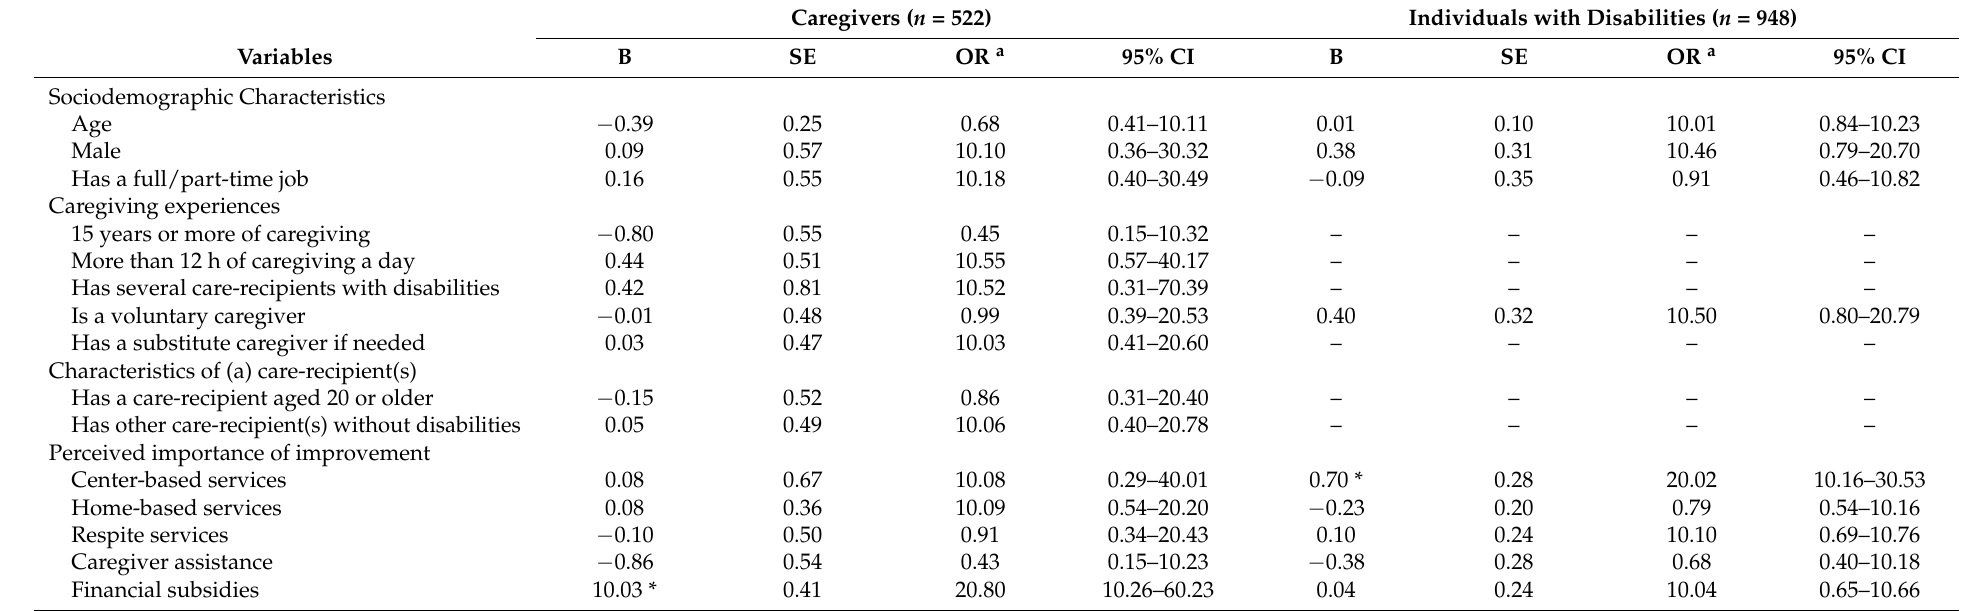
Table 5. Logistic regression models of self-efficacy for continuous community living ( N =